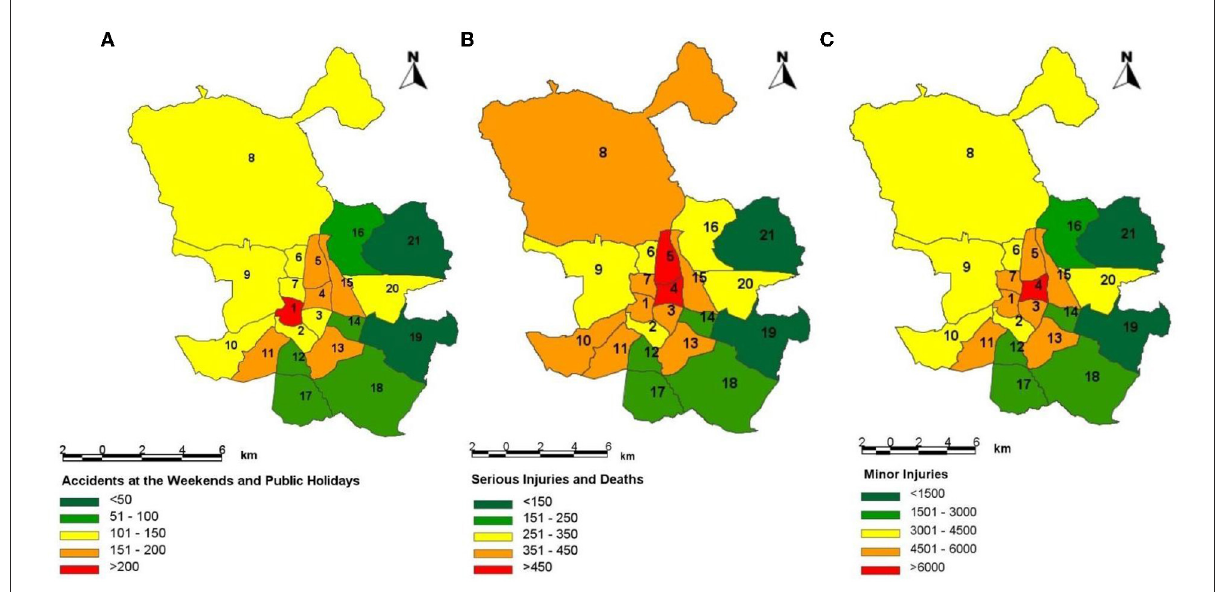
FIGURE2 (A) Number of accidents at weekends and public holidays; (B) number of serious injuries and deaths; and (C) number of minor injuries by district in Madrid in the period 2013–2019. Source: Own elaboration. 1-Center; 2-Arganzuela; 3-Retiro; 4-Salamanca; 5-Chamartín; 6-Tetuán; 7-Chamberí; 8-Fuencarral-El Pardo; 9-Moncloa-Aravaca; 10-Latina; 11-Carabanchel; 12-Usera; 13-Puente de Vallecas; 14-Moratalaz; 15-Ciudad Lineal; 16-Hortaleza; 17-Villaverde; 18-Villa de Vallecas; 19-Vicálvaro; 20-San Blas-Canillejas;